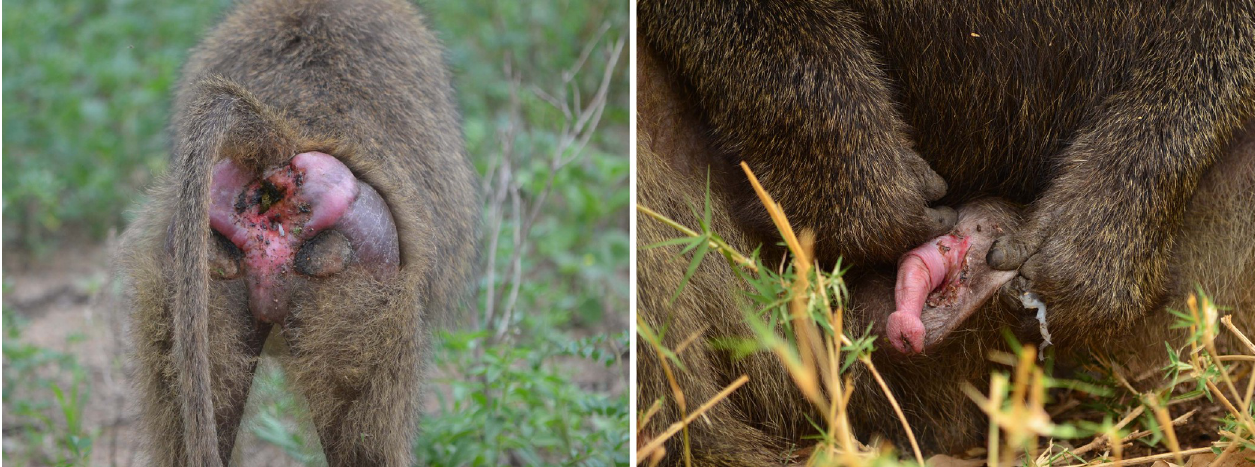
Fig 1. Genital skin ulcerations caused by Treponema pallidum subsp. pertenue. Olive baboon adult female (left) and adult male (right) at Lake Manyara National Park,